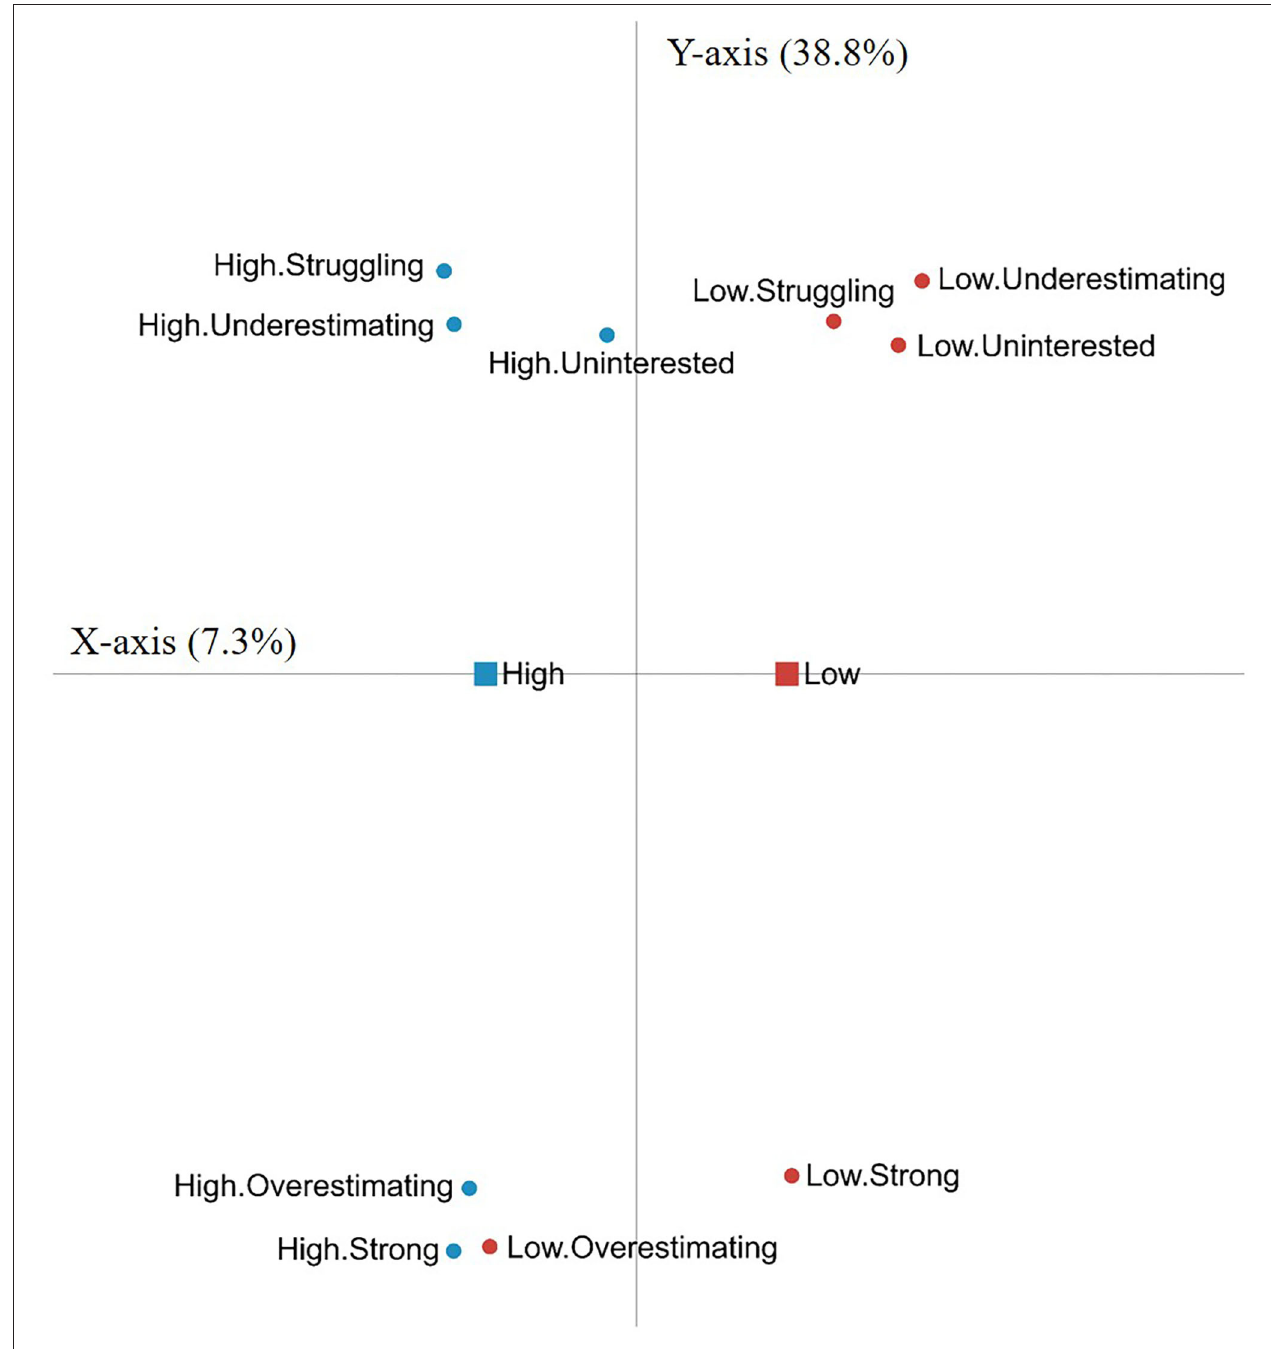
FIGURE 6 | Comparison of mean networks between student teachers with high and low judgment accuracy. High, High judgment accuracy (blue); Low, Low judgment accuracy (red). The figure presents the location of the centroids of the mean networks for HA and LA student teachers as squares. Centroids of the networks for each student profile are presented as points. The closer the centroids are located to one another, the more similar the network structures. The X-axis represents mean rotation, and the Y-axis represents the singular value that explains most of the variance in the data. Explained variance on the X-axis and Y-axis are 7.3 and 38.8%,